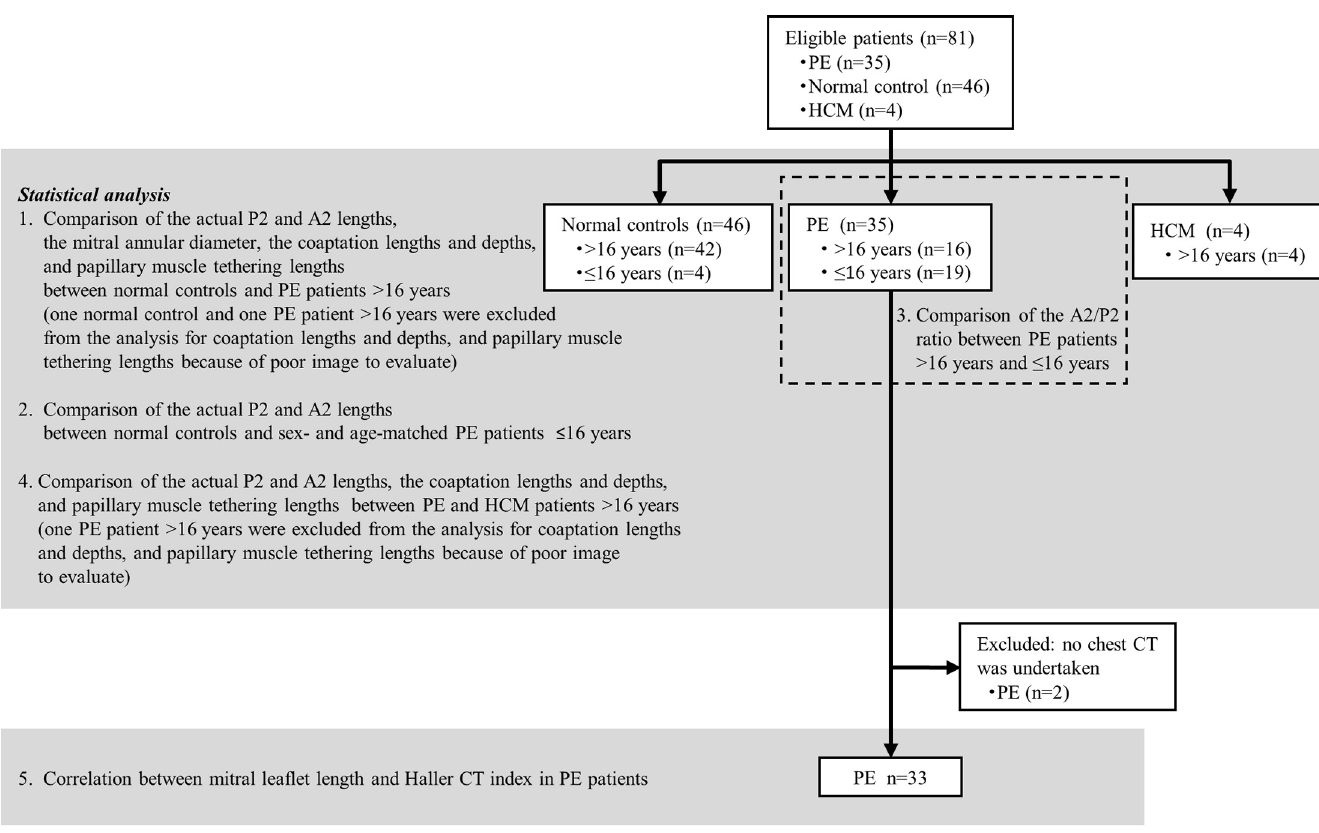
Fig 1. Flow chart of the